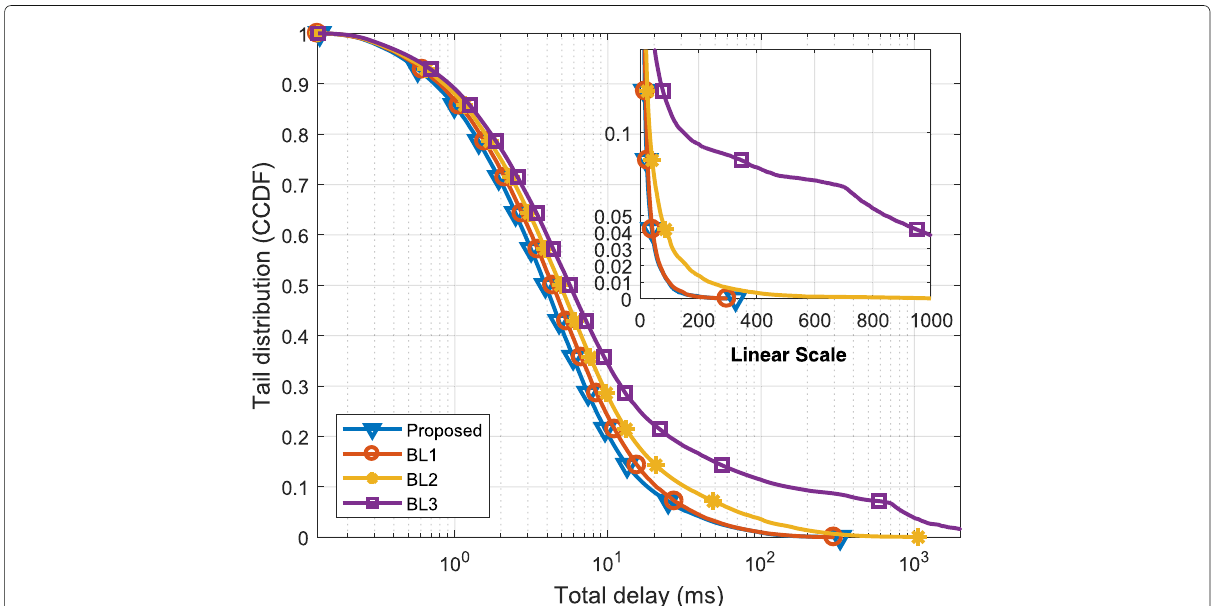
Fig. 3 The delay tail distribution. The total delay tail distribution for the proposed scheme (with a storage size s e of 10), and the baseline schemes, with E = 30 cloudlets, and UN density U / E = 3